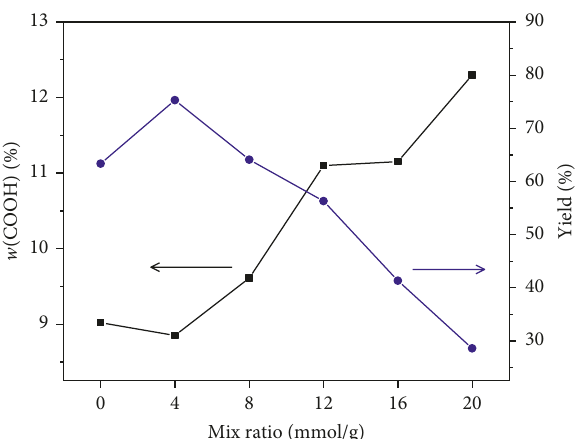
Figure 2: Effect of the reaction temperature on the yield and the content of carboxyl of LPCAs.